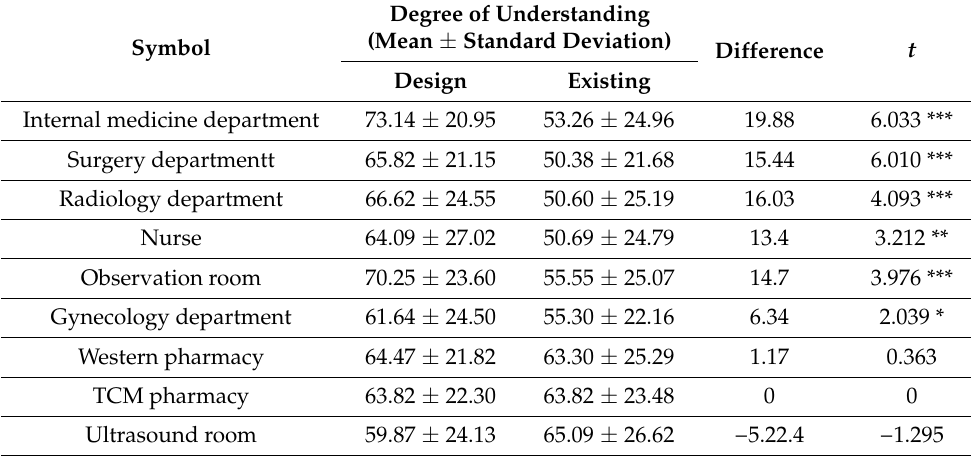
Table 1. Paired t -test results of symbols. Degree of Understanding (Mean ± Standard Deviation) Difference t Symbol Design